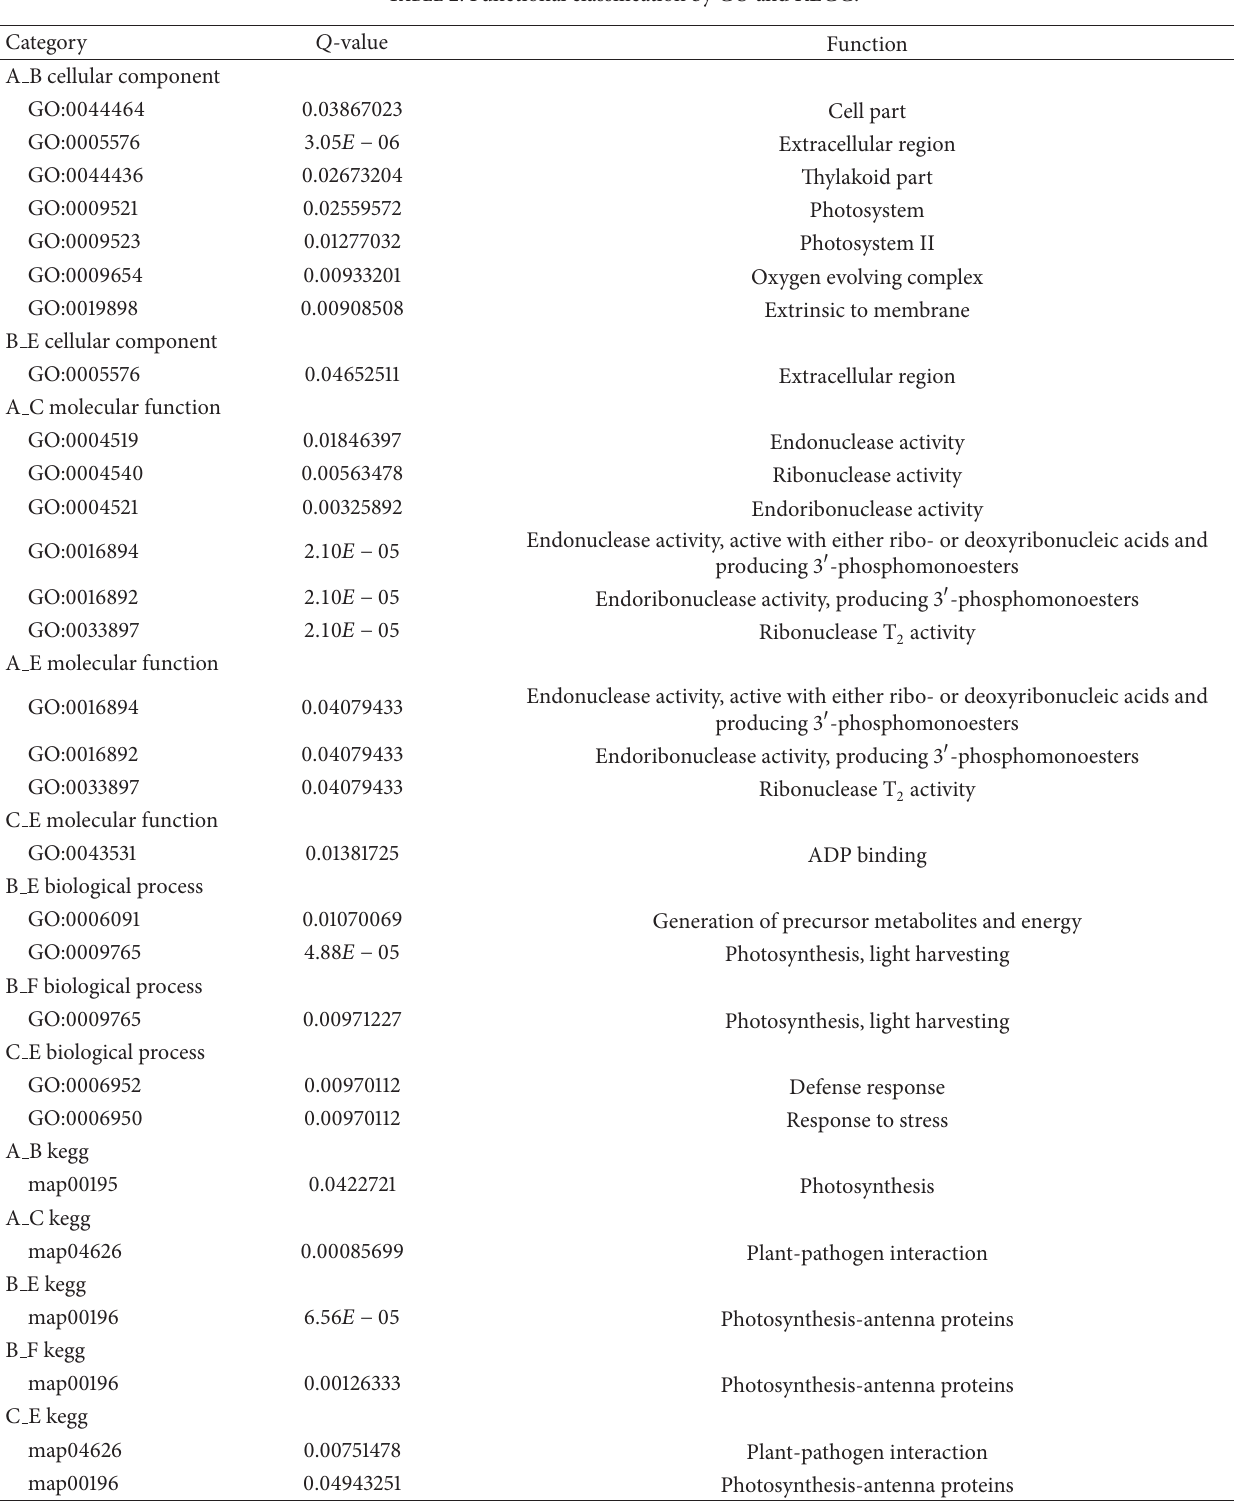
Table 2: Functional classification by GO and